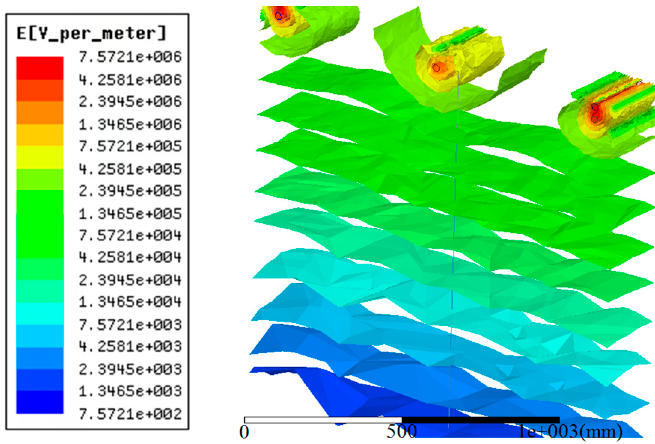
Figure 6. Electric field distribution of the 220 kV transmission lines.